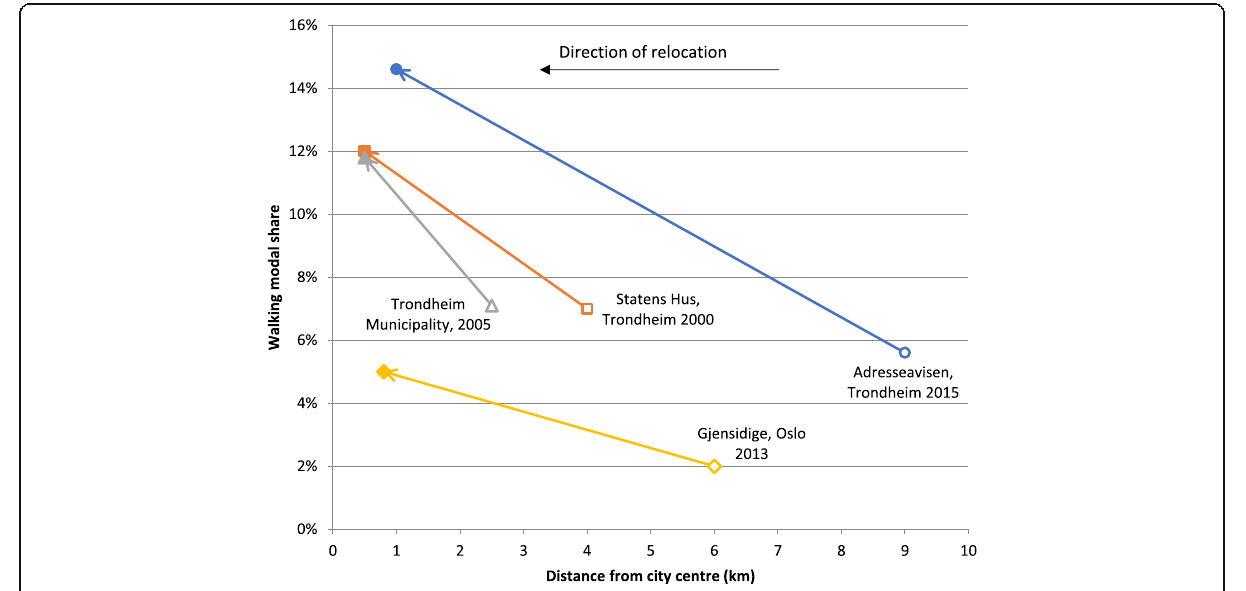
Fig. 5 Pedestrian modal share for commuting journeys before and after relocation from suburbs to the inner city